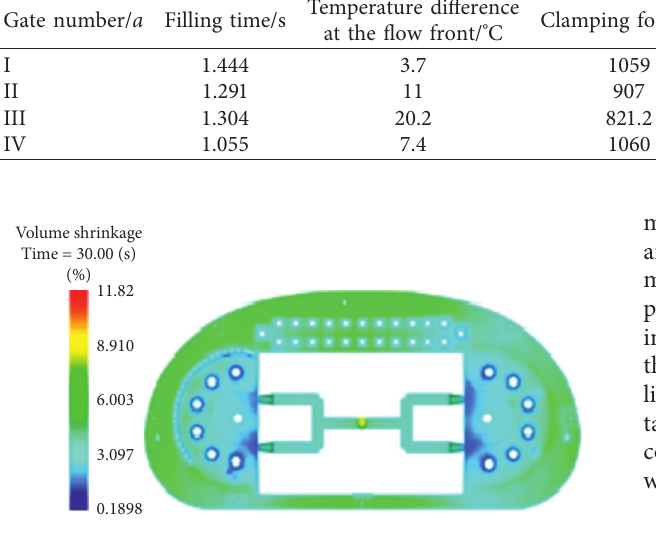
Figure 8: Volume shrinkage contour.